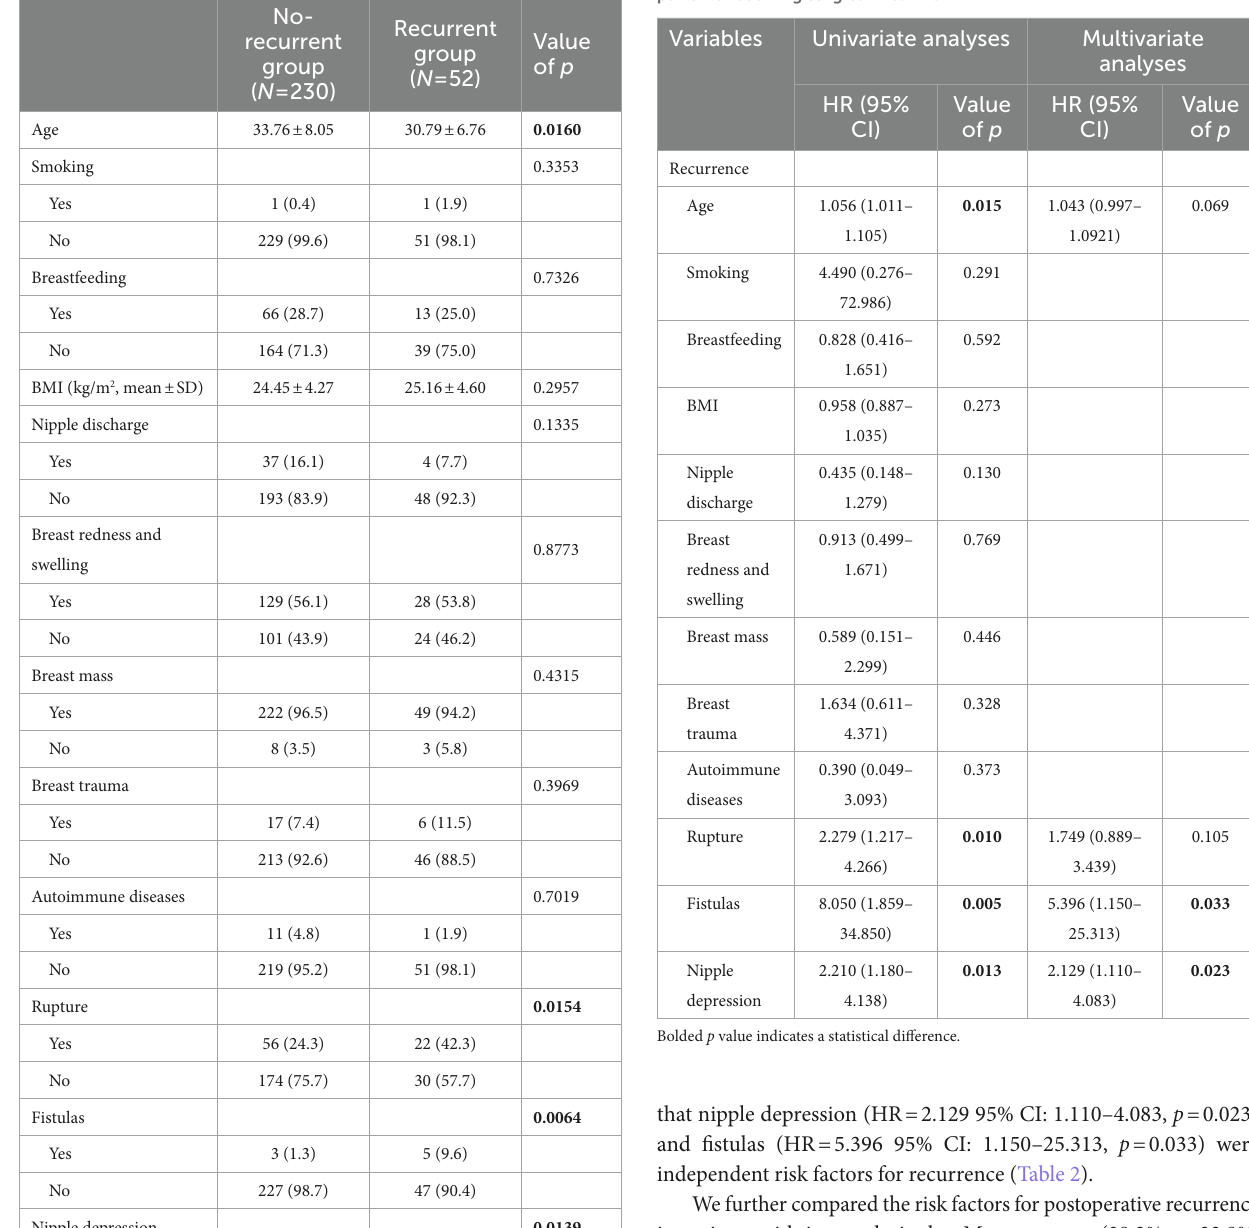
TABLE 1 Recurrence factors in PCM patients receiving surgical treatment. TABLE 2 Logistic regression for the predictors of recurrence in PCM patients receiving surgical treatment.